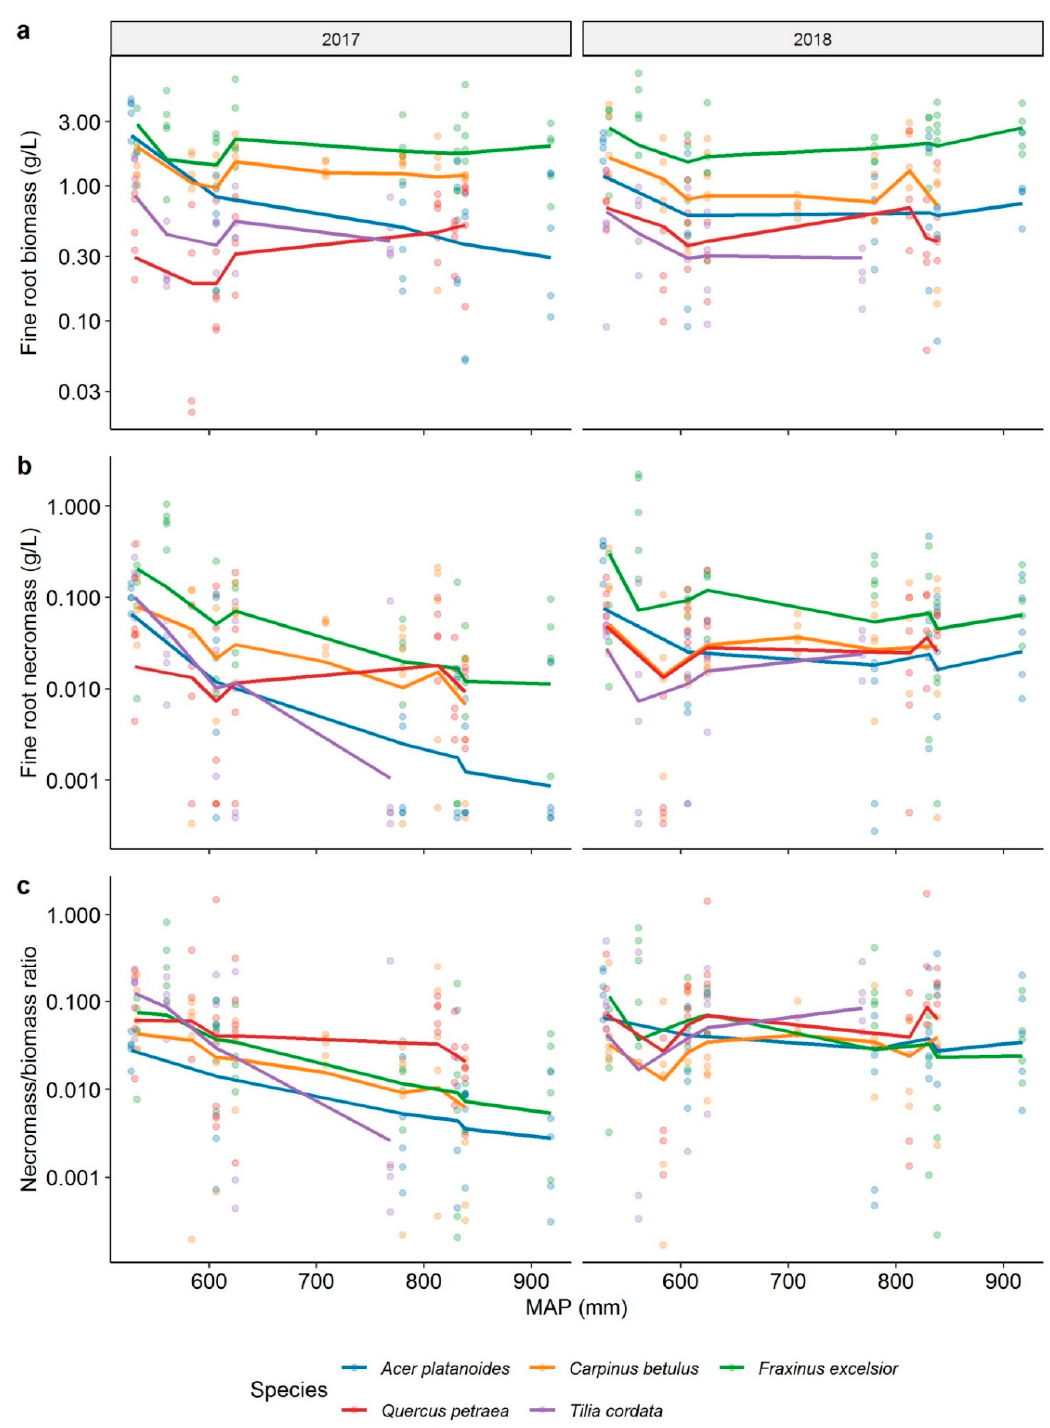
Figure 4. Fine root biomass ( a ), necromass ( b ), and necromass / biomass ratio ( c ) in the topsoil (0–10 cm) of the five species in relation to mean annual precipitation (MAP) in the 2017 and 2018 inventories. Data points are tree-level values, lines represent conditional predictions of the linear mixed effects model (the predictions of the fixed effect “MAP” for each species plus an intercept for each level of the random factor “site”). Note the log-scaled y-axis. The corresponding p and pseudo- R 2 values are summarized in Table 3. Graphs for the morphology variables are given in Figure A2 in the Appendix.